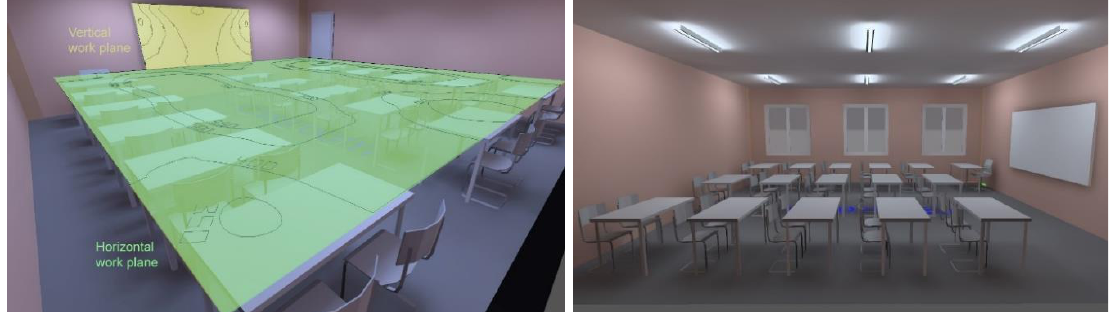
Figure 2 Work planes for